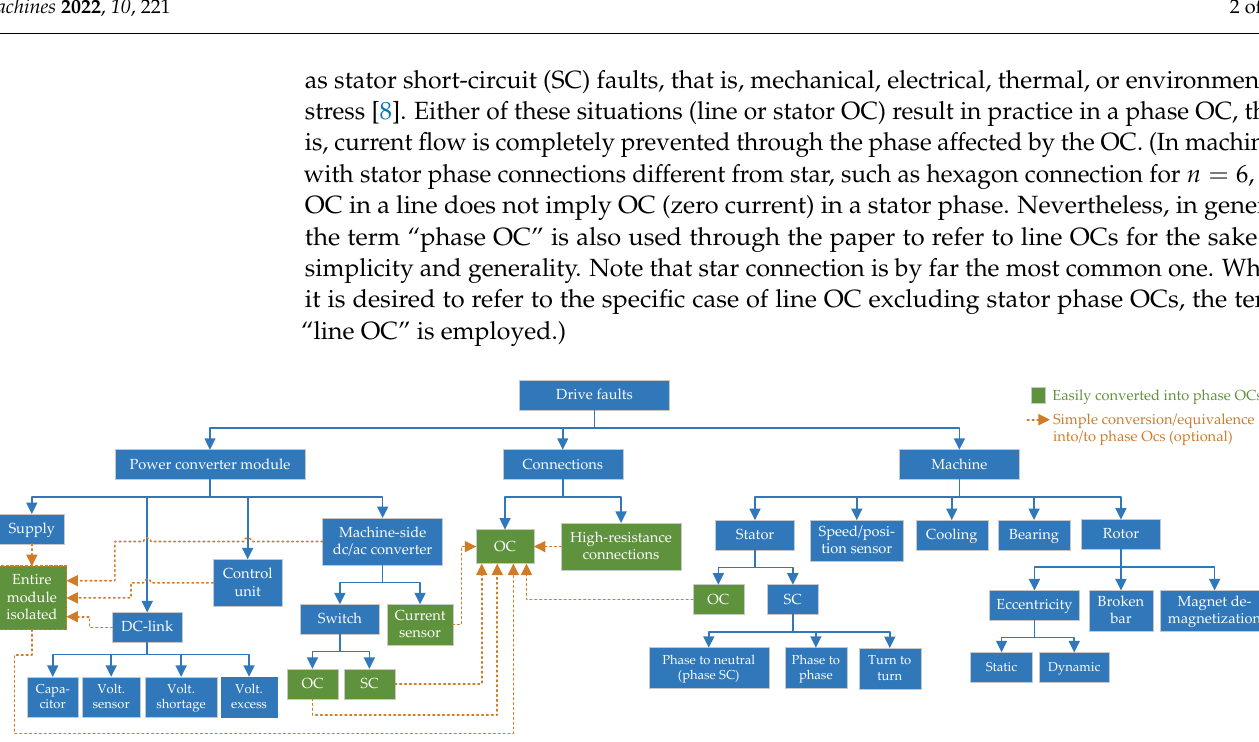
Figure 1. Types of faults in an ac